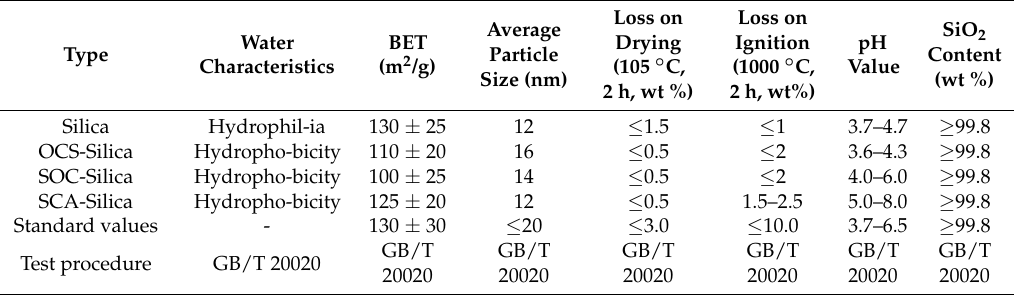
Table 2. Technical parameters of four nanosilica materials.